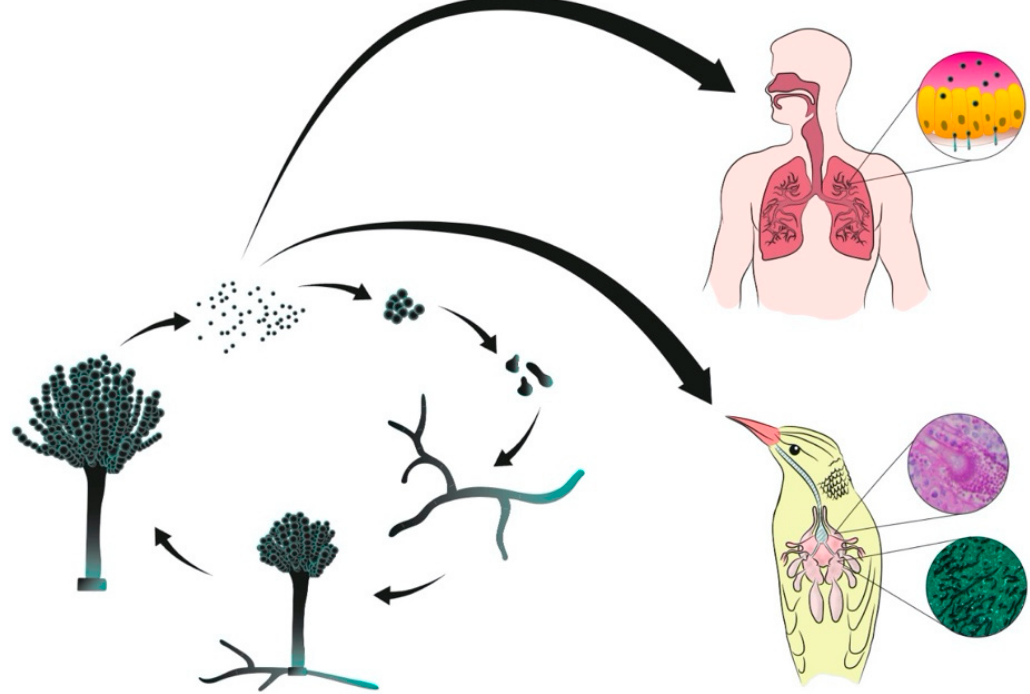
Figure 1. Representation of vegetative cycle of Aspergillus spp. and infection of human and avian hosts by inhalation of conidia.